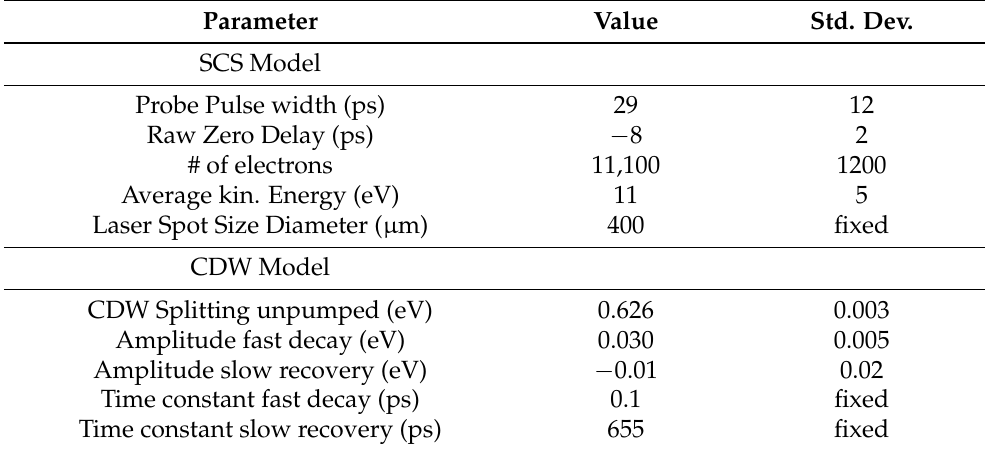
Table 2. Fitting results for the global fit of X-ray probe pulse width, delay zero and the CDW